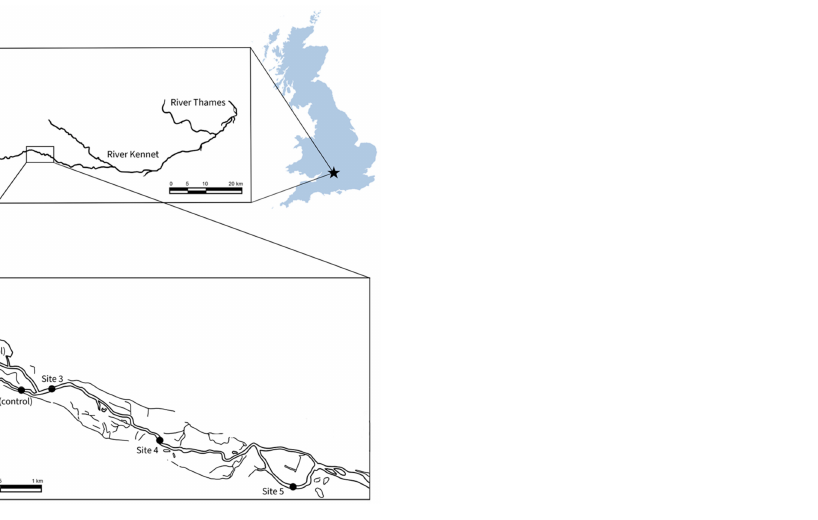
Figure 1. Location of the Kennet River restoration scheme ( a ) and the monitoring sites ( b